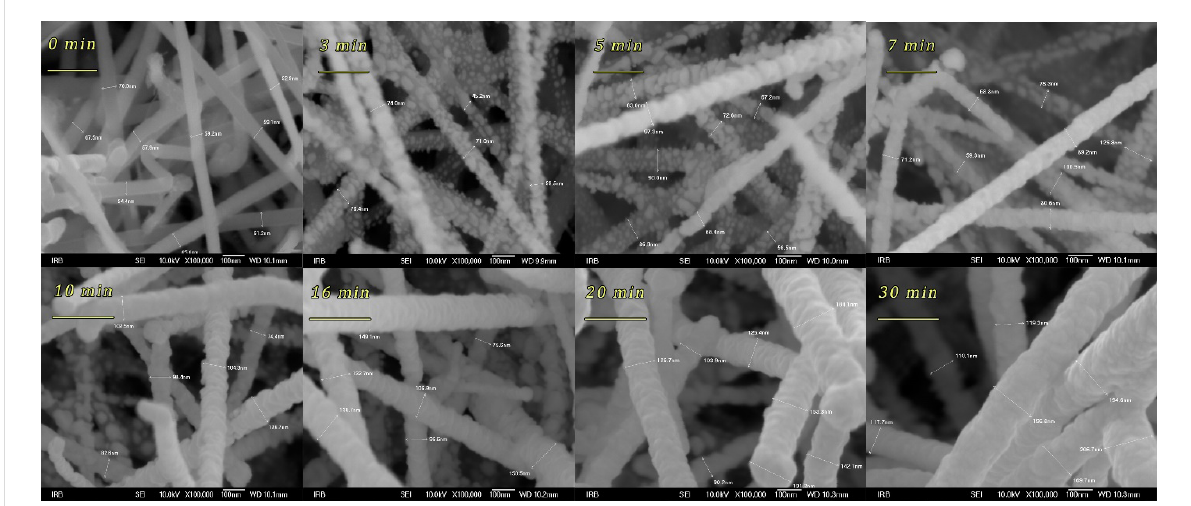
Figure 3: SEM images of horizontally in-plane randomly oriented SiNWs after different Ag sputtering times.